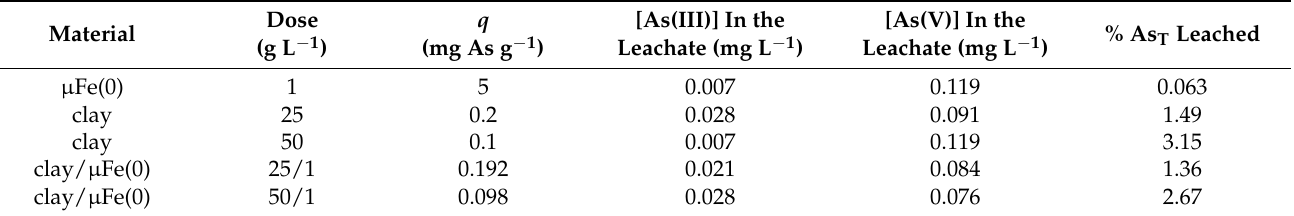
Table 5. Percentage of leachate of As T after the contact with water for 14 days of the solids recovered from experiments of As(III) removal with µ Fe(0), the clay, and their combination. Conditions of the initial experiments of Figure